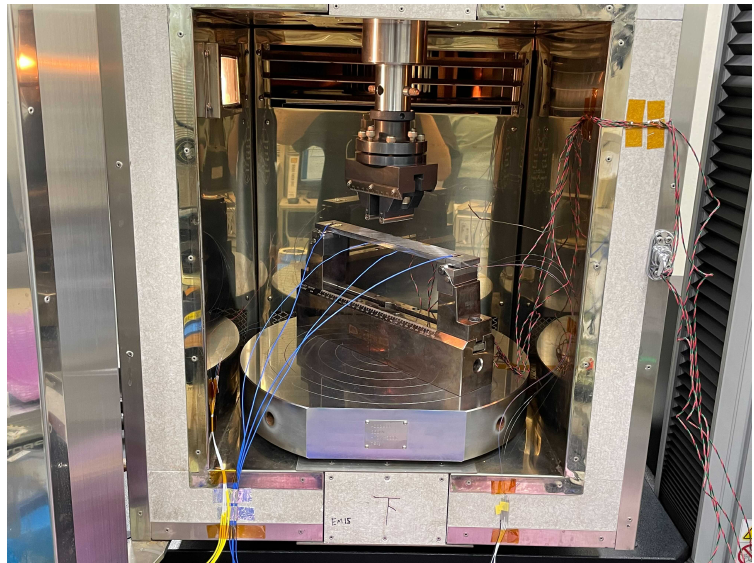
Figure 5. Specimen placed in an environmental